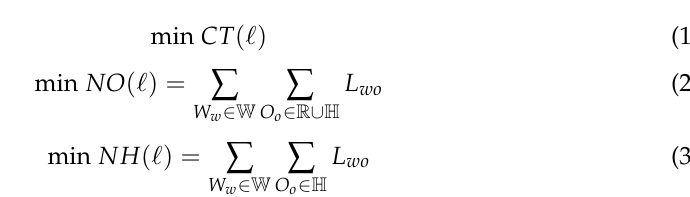
Table 2. The sets and parameters used in the model.